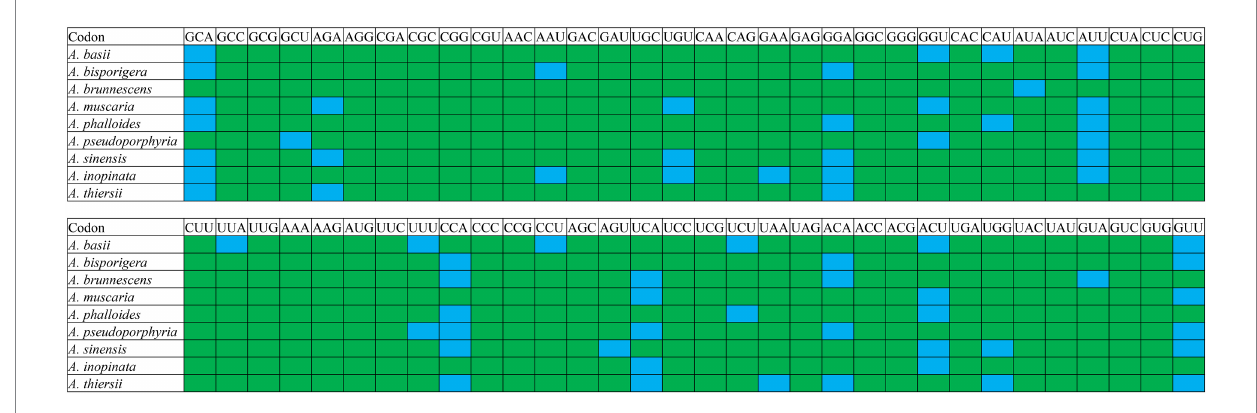
FIGURE 8 Optimal codons of nine Amanita species ( Δ RSCU > 0.08 and RSCU > 1), which are marked in